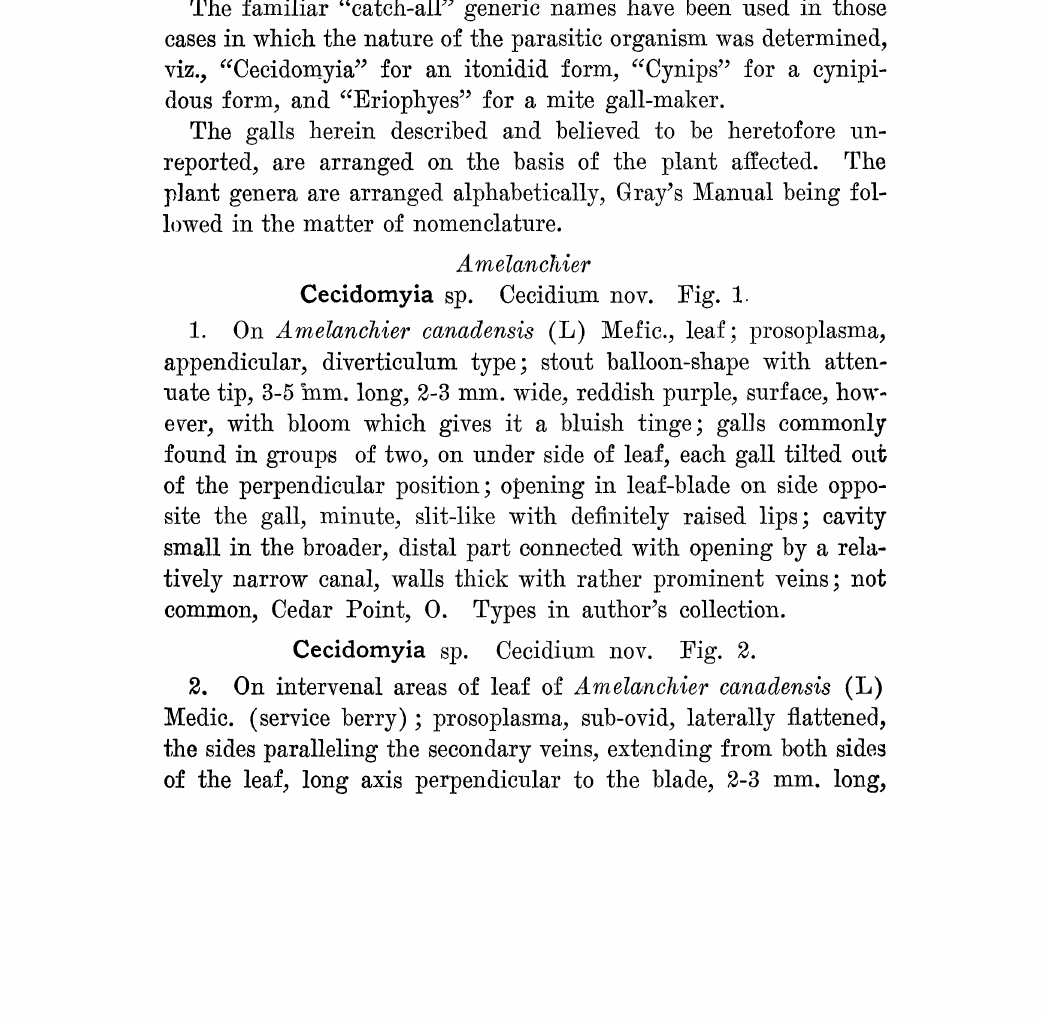
Cecidium nov. Fig.